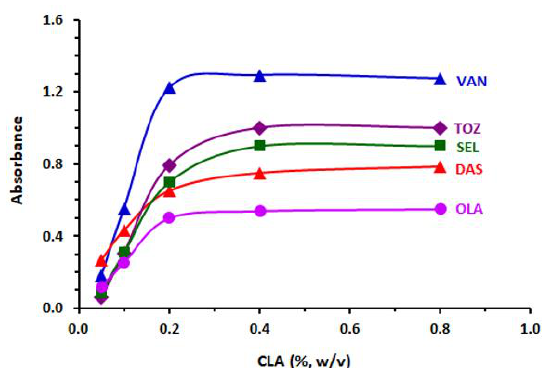
Figure 7. Effect of CLA concentration on its reaction with TKIs ( 200 µg/well). Measurements were carried out at 490 nm.